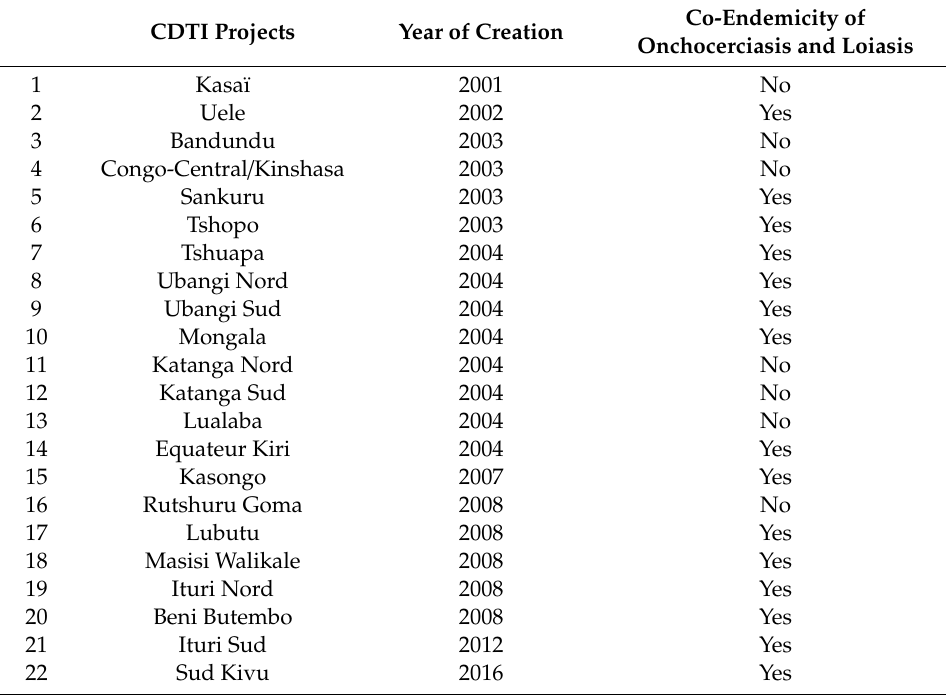
Table 2. Community-directed treatment with ivermectin (CDTI) projects in the DRC, year of creation, and projects co-endemic with